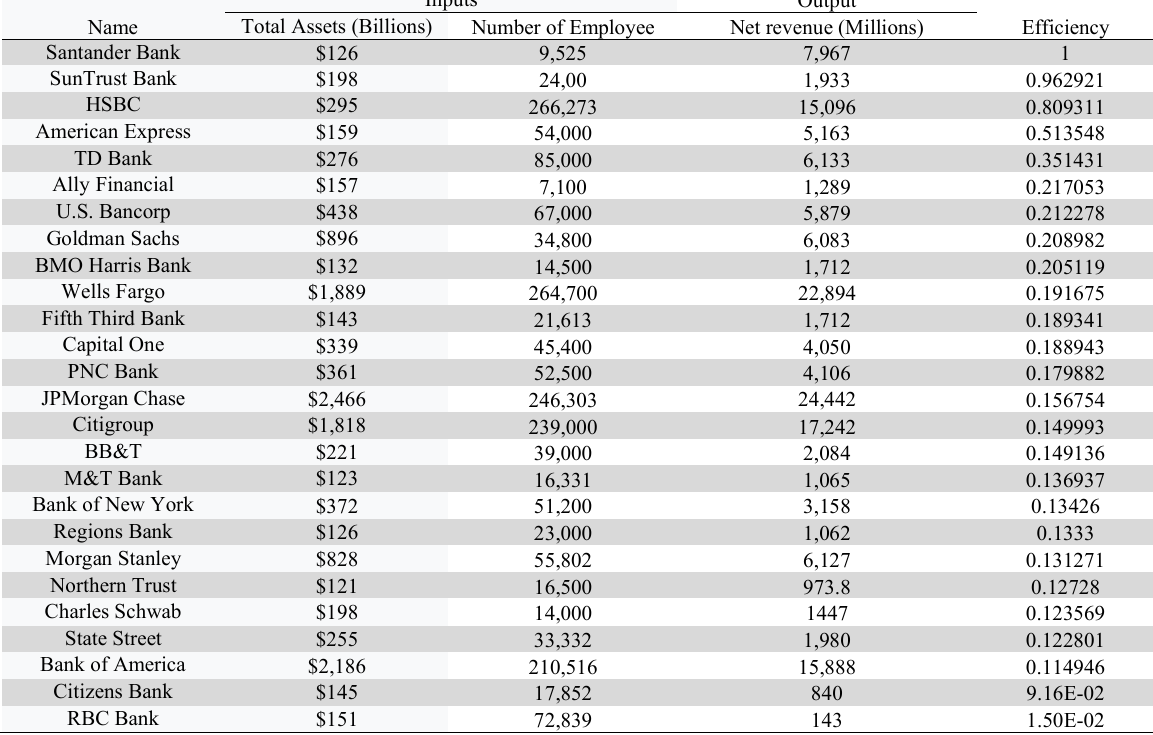
The results of the implementation of DEA